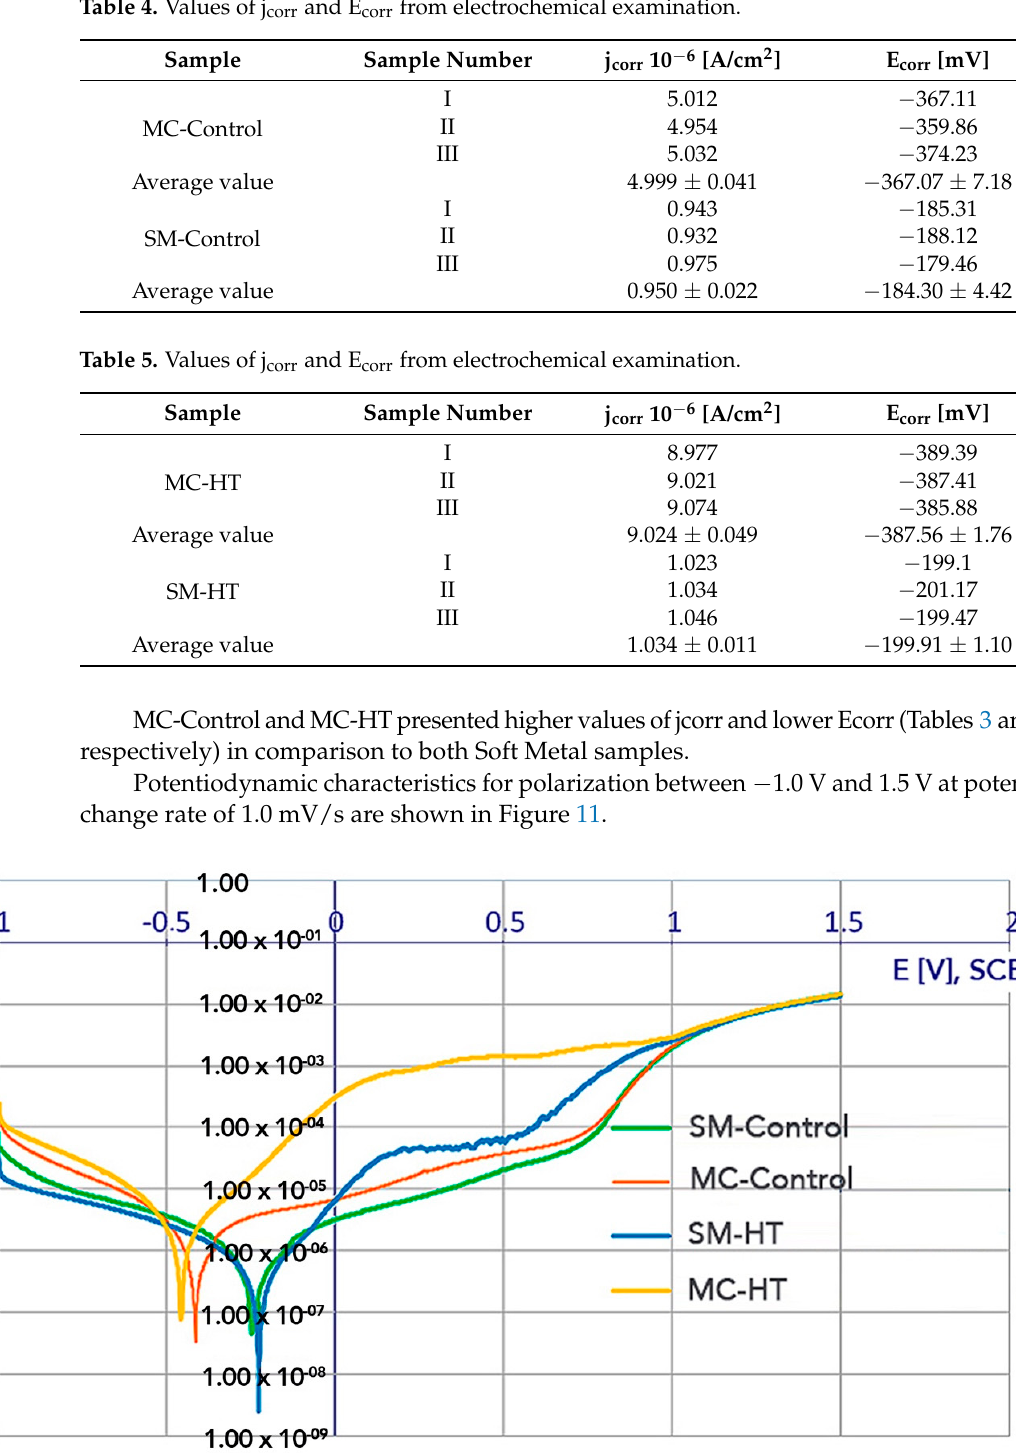
Figure 11. Potentiodynamic polarization curves in 0.9% NaCl solution. The potentiodynamic curves for the SM-Control and the SM-HT (control and HT) (Figure 11) were shifted in the positive direction, anode current densities were lower than for the MC-Control and the MC-HT. For the MC-HT, the shift of the potentiodynamic curve to the left and a marked increase in anodic current values were observed. The SM-Control, MC-Control and SM-HT showed a passivity in a relatively wide range of potentials in which the current density slightly increased linearly until a break- down potential was reached. The part of the polarization curve above the breakdown po- tential (E br ) for the SM-Control (E br = 0.785 V) and the MC-Control (E br = 0.710 V) was characterized by an increase in the current due to the dissolution of the protective oxide films and water oxidation (as the potential of the oxygen-evolution in the neutral saline solution was about ~0.6 V). The value of E br for the SM-HT was equal to 0.560 V. There was no evidence of abrupt increase of current for the MC-HT, but the anodic part of the polarization curve presented high values of current densities (~1–2·× 10 − 3 A/cm 2 ).